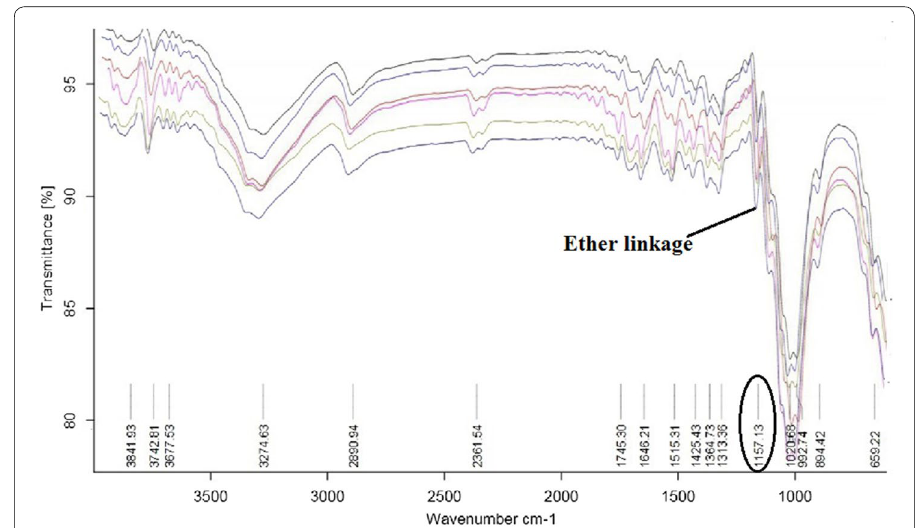
Fig. 7 FTIR analysis of a MCT β-CD treated cotton at optimized process parameters (without wash), b MCT β-CD treated cotton after wash 1, c after wash 2, d after wash 3, e after wash, 4 f after wash 5